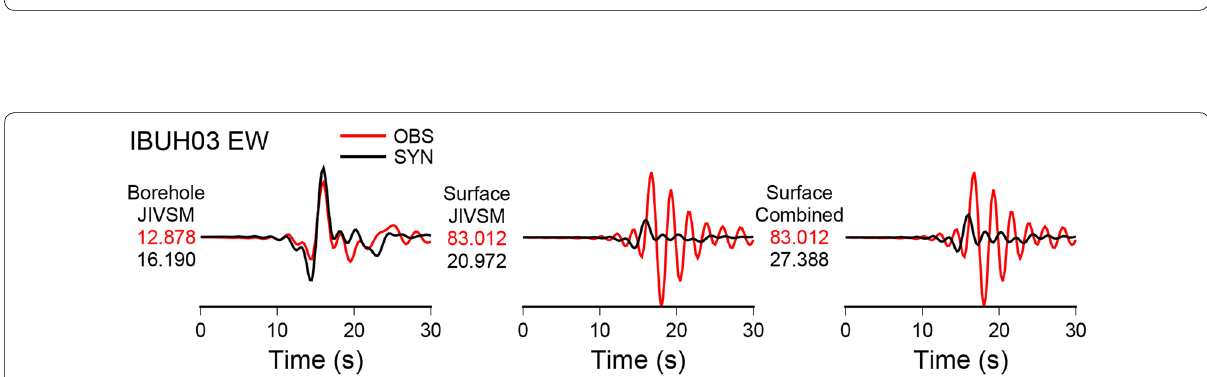
Fig. 4 Additional inversion results for the single fault-plane model. a Cross section of the same region as in Fig. 2b but for the single fault-plane model. b Slip distribution. The white star denotes the rupture initiation point. c Observed (red) and synthetic (black) and observed (red) strong motion waveforms. Station names, components, and the maximum amplitude of the observed waveforms (cm/s) are shown to the left of each waveform